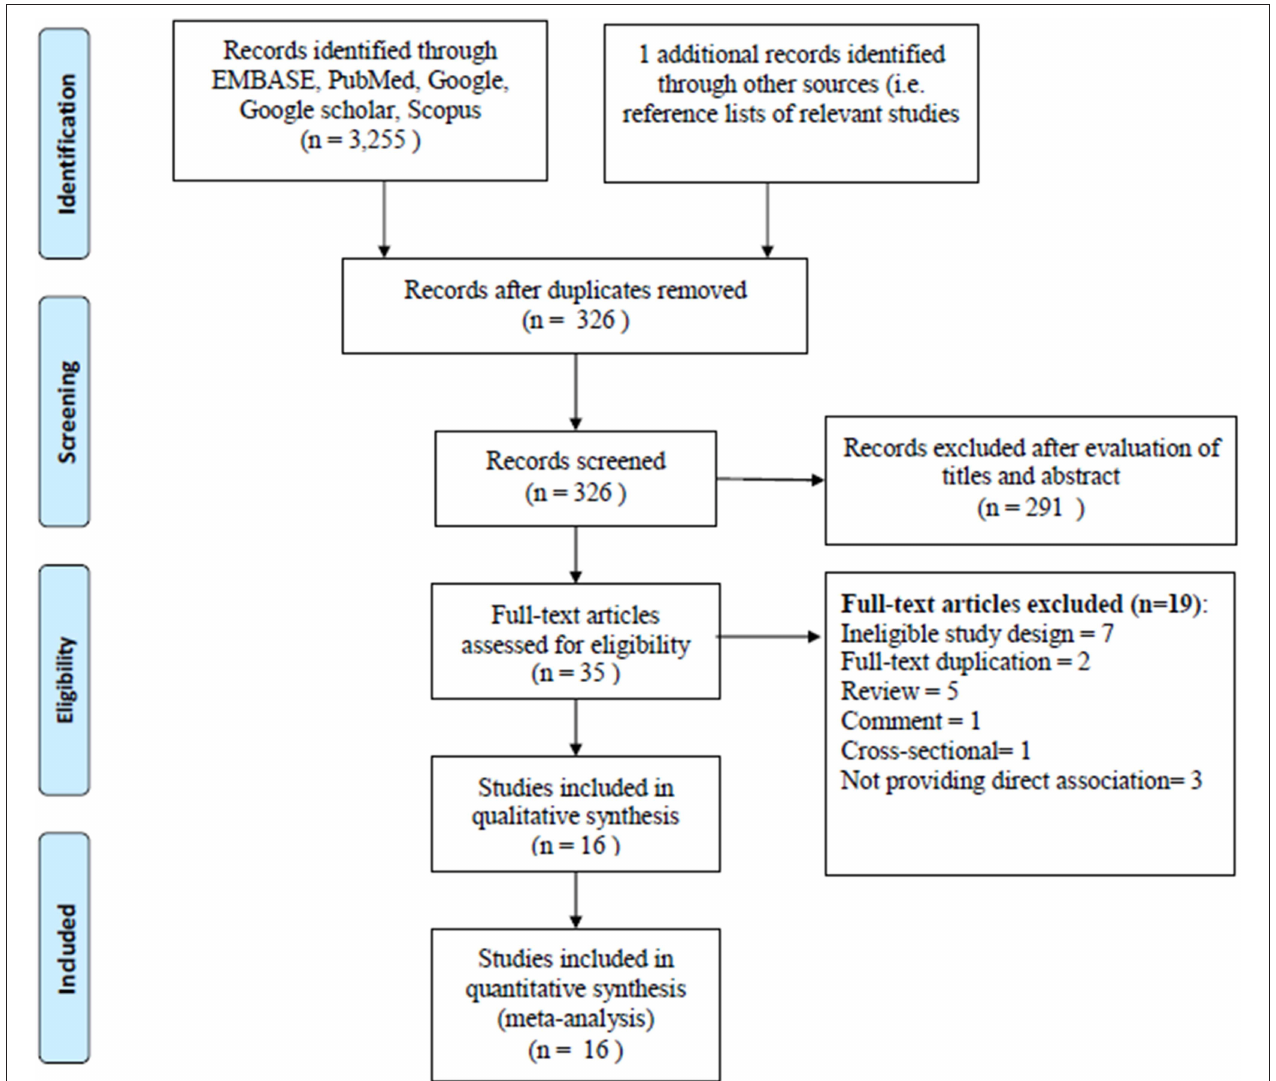
FIGURE 1 | PRISMA flow diagram for study